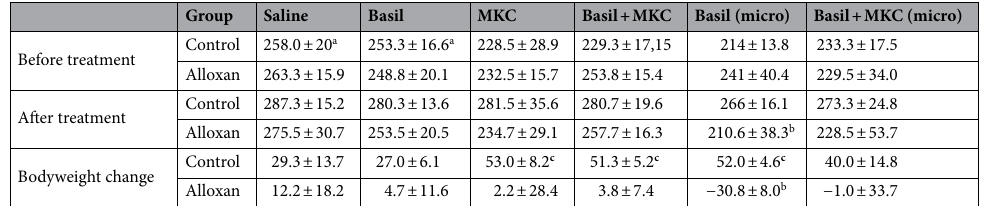
Table 1. Bodyweight values ((g), x ± SD) in the control and experimental groups (6 animals per group). a p < 0.05 in relation to the control group treated with basil (micro). b p < 0.05 in relation to the alloxan group treated with saline. c p < 0.05 in relation to the control group treated with saline, or